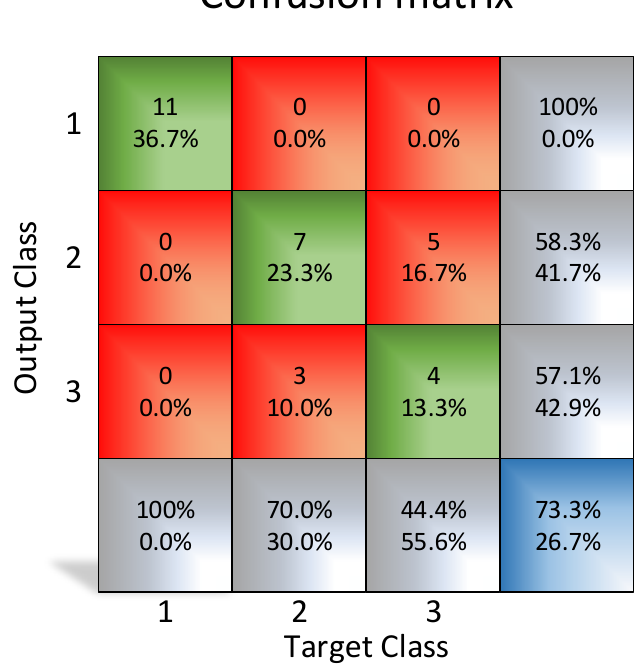
Figure 12. Confusion matrix using 10 × 10 resolution images.